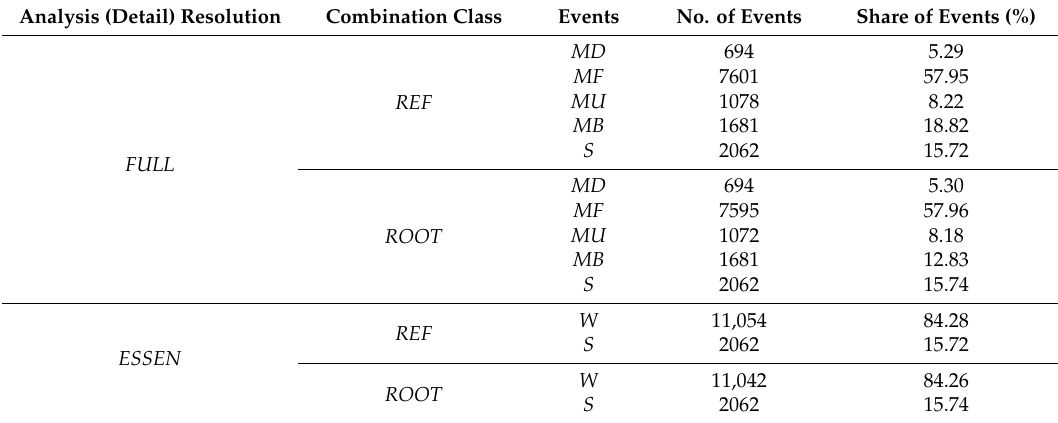
Table 4. Absolute and relative frequency of the events in the signals